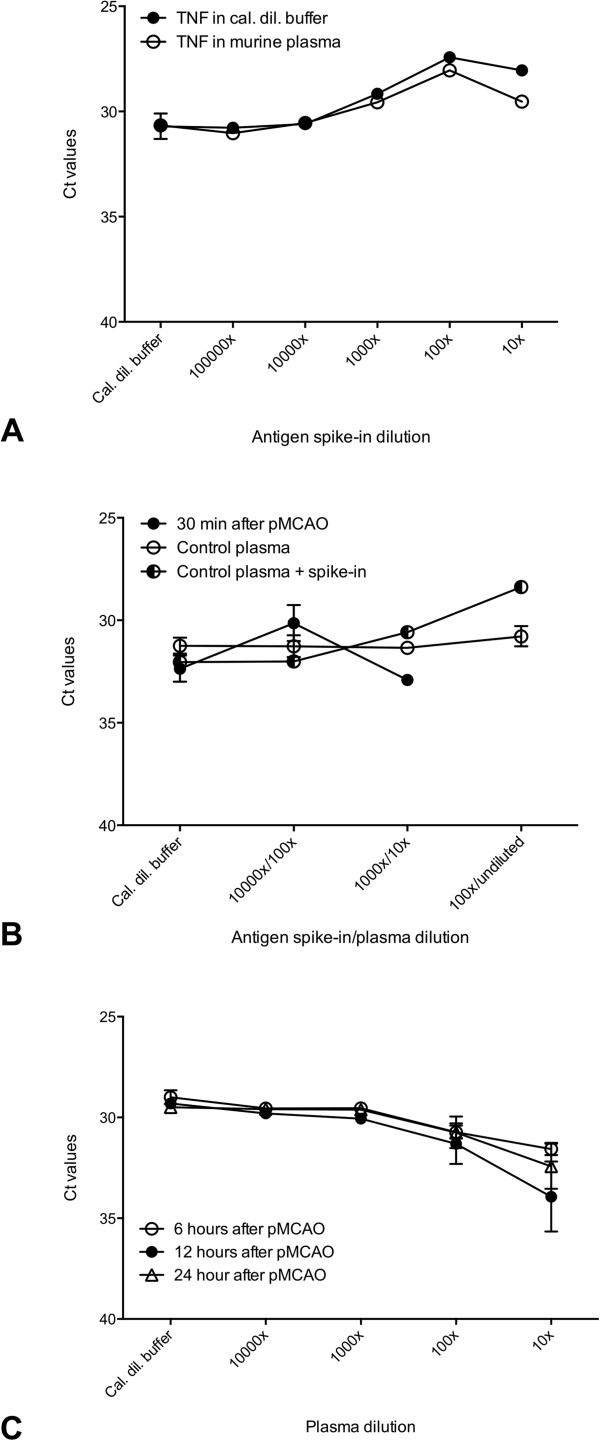
Proseek analysis of TNF levels in plasma. (A) The performance of the Proseek TNF assay was evaluated by comparing series of dilution curves of TNF spiked in either Calibrator diluent buffer or mouse EDTA plasma. Recombinant TNF was spiked in Calibrator diluent buffer or mouse EDTA plasma and measured by Proseek TNF assay. The fold dilution is indicated on the x-axis and the signal is plotted as crossing point (Cp) values. The very similar curves illustrate full recovery in plasma, the linear range shows assay efficiency and the hook effect at 10× dilution indicates assay saturation. (B) TNF levels in plasma after pMCAO. Plasma samples were obtained 30 minutes after pMCAO and measured in the indicated dilutions (100×, 10× and undiluted). As a positive control to ensure assay performance TNF was spiked in control plasma (Calibrator diluent buffer, 10,000×, 1,000× and 100×) and as negative control plasma from a naïve control mouse (100×, 10× and undiluted). No change in TNF in plasma was observed 30 minutes after pMCAO. (C) TNF levels in plasma after pMCAO. Plasma samples were obtained 6, 12 or 24 hours after pMCAO and TNF levels were analyzed at the indicated dilutions (10,000×, 1,000×, 100× and 10×). The TNF level was at background levels and no change in TNF in plasma was observed at the indicated time points after ischemia. Plasma inhibition was introduced in the assay setup, demonstrated by lower signal in the high plasma concentration compared to the buffer level. In (A), (B) and (C) error bars indicate SD.